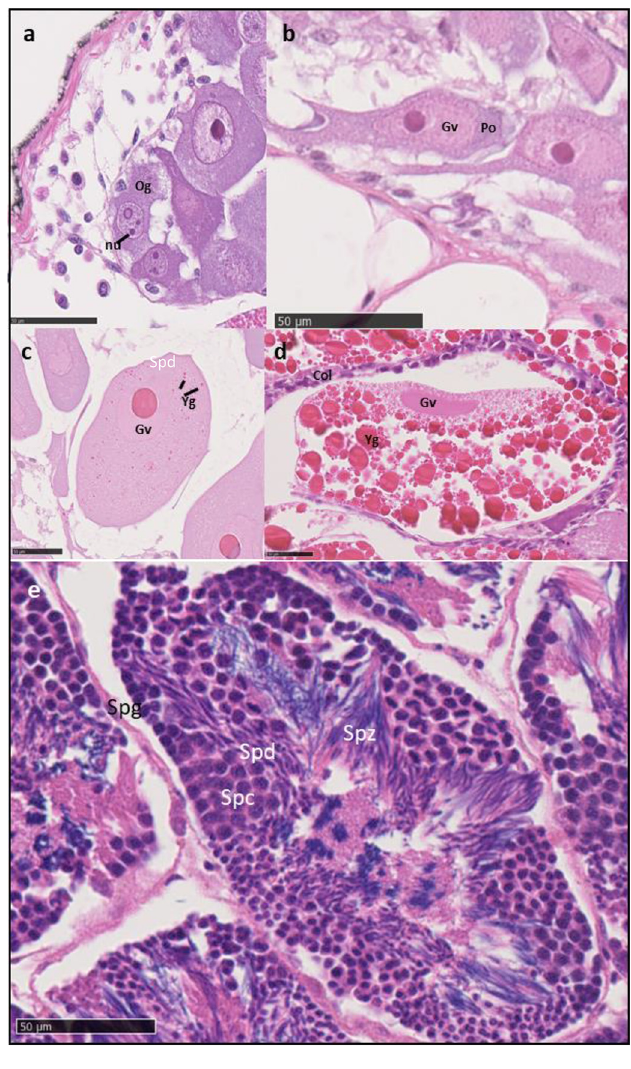
Fig. 3. Light microscopy of gametogenesis in T. mutabilis